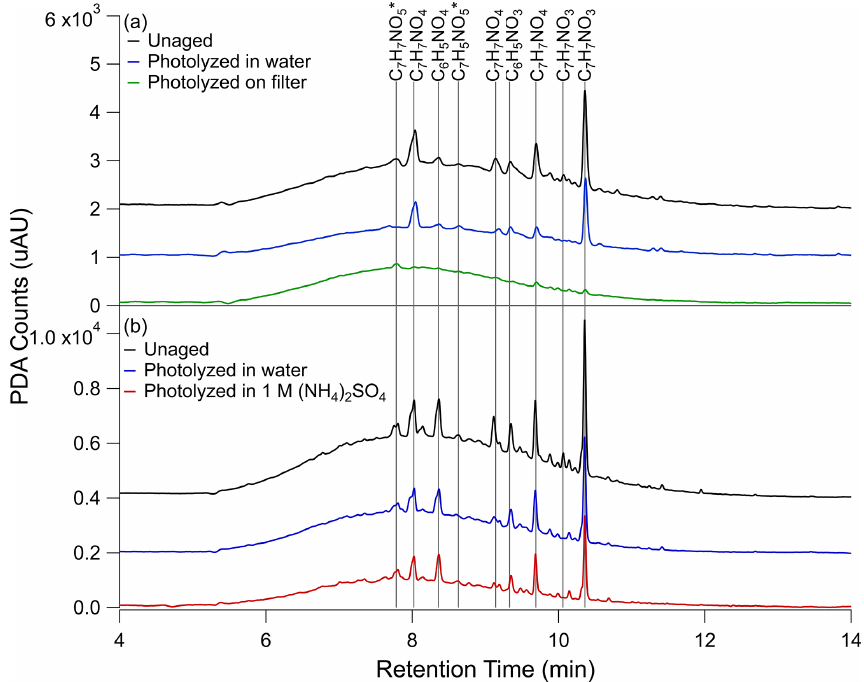
Figure 2. UPLC-PDA chromatograms for (a) unaged toluene SOA sample (black trace), sample photolyzed 5h in water (blue trace), and sample photolyzed 5h on the filter (green trace) from Filter 3 and (b) unaged toluene SOA sample (black trace), sample photolyzed 5h in water (blue trace), and sample photolyzed 5h in 1M ammonium sulfate (red trace) from Filter 4. The black (unaged) and blue (photolyzed in water) traces are shown twice to illustrate the extent of reproducibility of this analysis. PDA counts were integrated over 300 to 680nm wavelength range to match with the UV–Vis data analysis. A blank PDA spectrum, also integrated from 300 to 680nm, was subtracted from each PDA spectrum shown here. The blank PDA chromatogram can be seen in Fig. S7, along with the PDA data for the control samples. The peaks for which molecular formulas could be assigned are marked on the graph, and their assigned formulas are indicated, while asterisks denote unnamed formulas. In the case of 1M ammonium sulfate, PDA counts were adjusted for the estimated 50% extraction efficiency. Additionally, the baselines are each offset by 10 3 PDA counts on the y axis of (a) and 2 × 10 3 PDA counts on the y axis of (b) for ease of